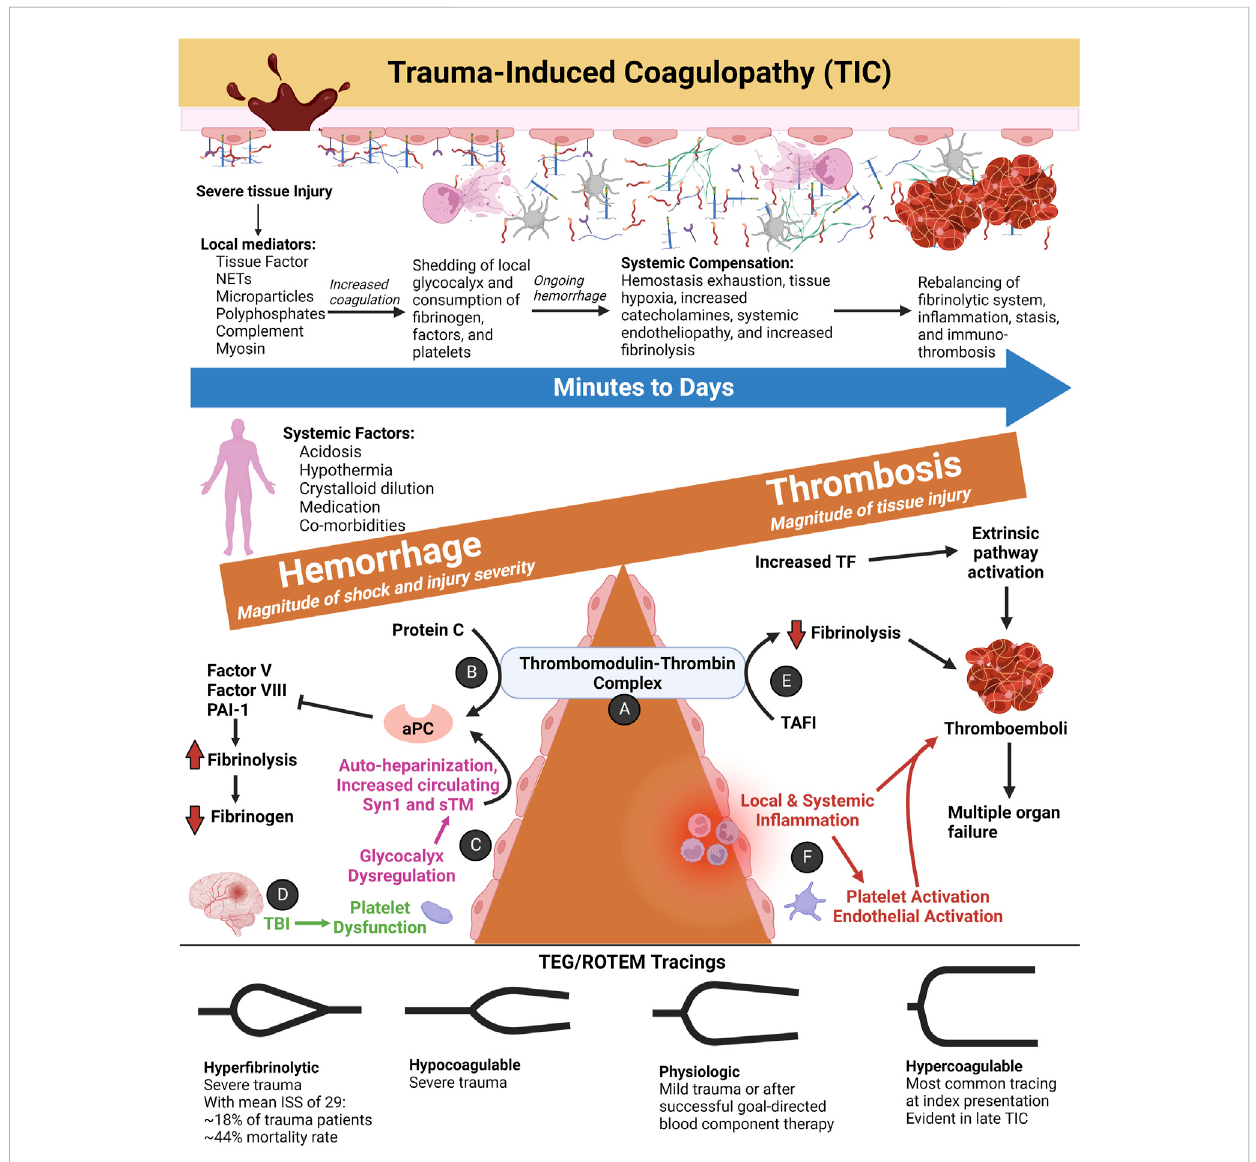
FIGURE 8 The Spectrum of Trauma-Induced Coagulopathy (TIC) as a Function of the Thrombomodulin-Thrombin Complex and SHINE. Hypercoagulability presents most commonly at index trauma presentation according to thromboelastography (TEG) and rotational thromboelastometry (ROTEM) tracings (Johansson and Ostrowski, 2010). As injury severity and the magnitude of hemorrhagic shock increase, the likelihood of hypocoagulability and/or hyper fi brinolysis increases in tandem (Johansson and Ostrowski, 2010; Moore et al., 2016a). Other anti-hemostatic factors at index may include acidosis, hypothermia, crystalloid resuscitation resulting in dilutional coagulopathy, pre-trauma anticoagulant or antiplatelet medications, and co- morbidities(Mooreetal.,2021a).Aftersuccessfulinitialresuscitation,patientsmostoftendemonstratehypercoagulabilityandvenousthromboembolism in the ensuing days. On the other hand, persistent fi brinolytic shutdown at 24 h post-injury correlates greatest to the magnitude of tissue injury. (A) The thrombomodulin (TM)-thrombin complex is one proposed hypothesis to explain TIC hemostatic phenotypes (Walsh et al., 2019). (B) In its anticoagulant role, the endothelial membrane-bound TM binds with thrombin to convert protein C to activated protein C (aPC). TM-thrombin action on protein C may alsobeacceleratedbyendothelialproteinCreceptor(EPCR,notshown).APCinactivatesFactorV,FactorVIII,andplasminogenactivatorinhibitor-1(PAI- 1) to decrease coagulation and promote tissue plasminogen activator (tPA) activity to convert plasminogen to plasmin (Gando et al., 2018). The resulting fi brinolysis leads to hypo fi brinogenemia and a hypocoagulable state as demonstrated by viscoelastic markers. APC and fi brinogen levels share an inverse relationship whereby the TM-thrombin complex increases protein C activation with decreasing fi brinogen levels, leading to a greater anticoagulant and pro- fi brinolyticstate (Diez et al.,2006).On thecontrary, with increased fi brinogen, the TM – thrombin complex isinhibited from activating protein C.As a result of glycocalyx dysfunction, activation of protein C, enhanced fi brinolysis, and low fi brinogen, the maladaptive response caused by consumption of clotting factors and platelets leads to high fi brin/ fi brinogen degradation products (FDPs) with an overall anti-hemostatic state (Diez et al., 2006; Dobson et al., 2015). (C) Tissue hypoperfusion and endothelial injury causes shedding of the endogenous HS of the glycocalyx with subsequent “ auto- heparinization ” (Ostrowski and Johansson, 2012). The sensitivity of TEG/ROTEM to detect auto-heparinization remains questionable (Zipperle et